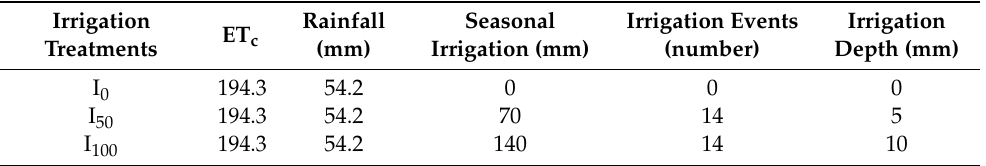
Table 2. Crop evapotranspiration (ETc, mm), rainfall (mm), seasonal irrigation (mm), number of irrigation events and irrigation depths of each (mm) for the three irrigation treatments (I 0 , I 50 , I 100 ) starting from DAT 0 (May 16).